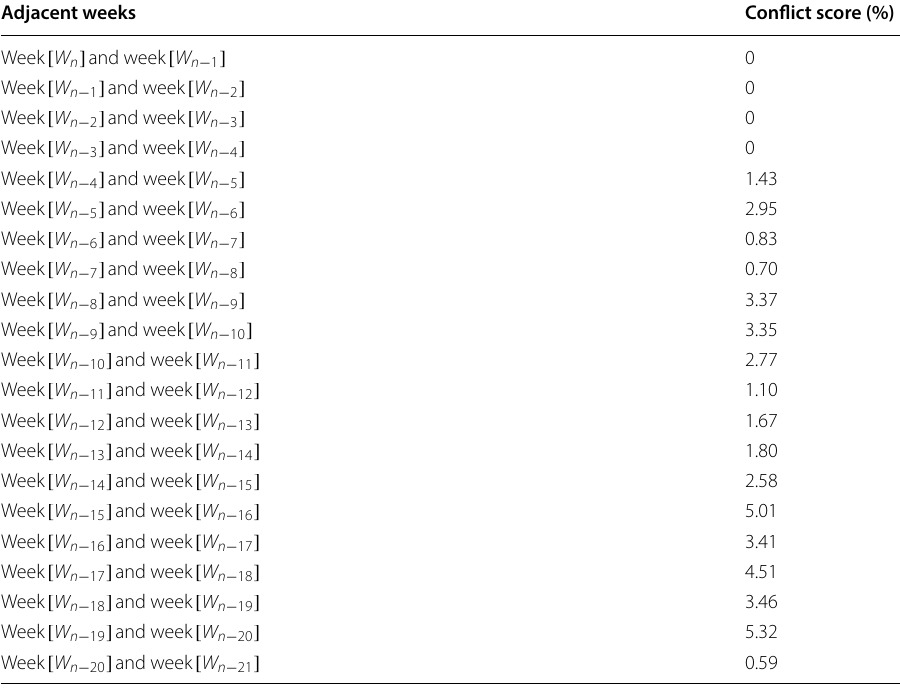
Table 1 Conflict score count for a sample user utilizing the dataset (CDS06) Adjacent weeks Conflict score